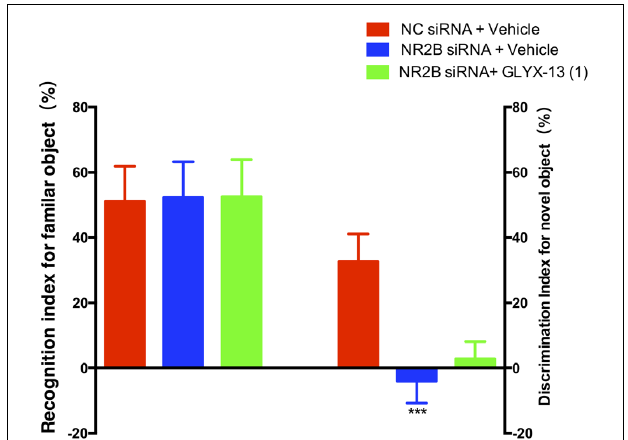
FIGURE 7 | GLYX-13 did not reverse the object recognition deficits induced by NR2B siRNA in the mice during the NORT. The recognition index of the familiar objects and the discrimination index for the novel object are shown. Data represent the mean ± SEM ( n = 12 per group; ∗∗∗ P < 0.001, versus the NC siRNA + vehicle-treated group).